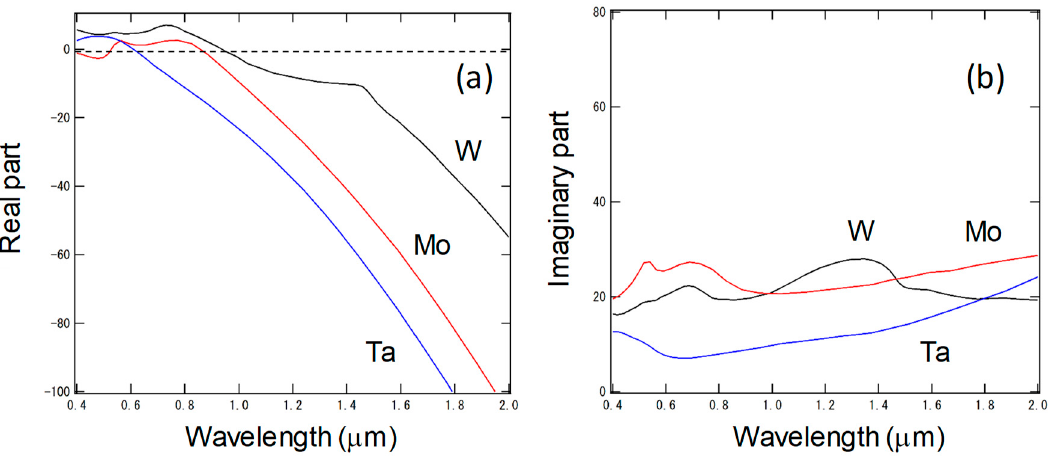
Figure A2. Spectral relative permittivities of conventional refractory metals (W, Ta, and Mo): ( a ) real and ( b ) imaginary part of the relative permittivity [41].